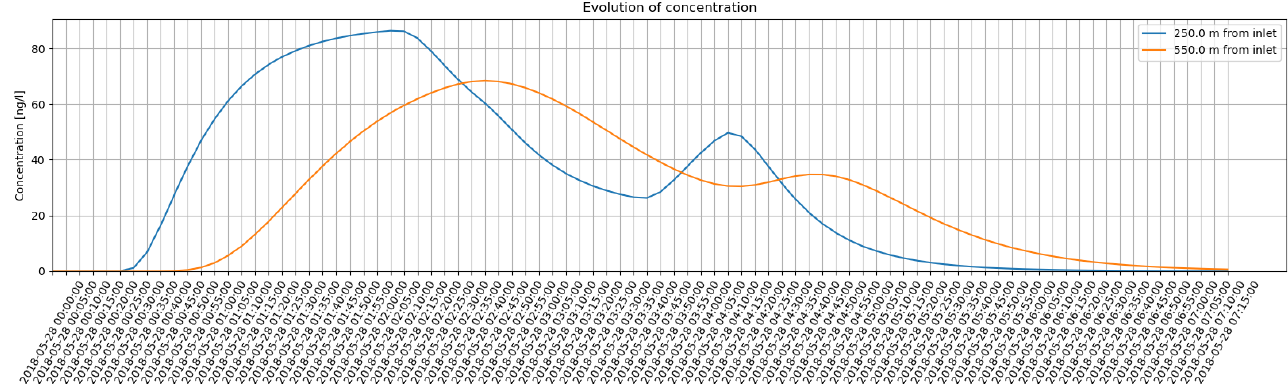
Figure 6. Example graph: solution at a selected time as function of distance from the inlet point.